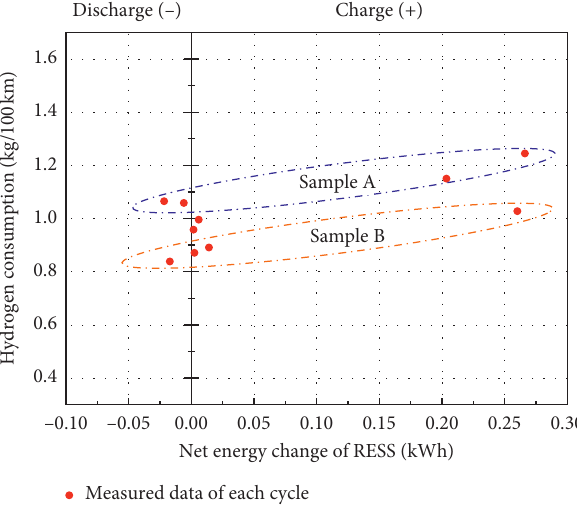
Figure 3: Test results of H